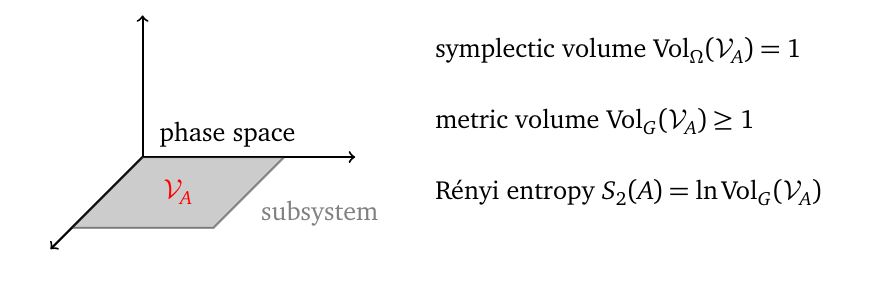
Figure 2: Geometric interpretation of Rényi entropy. We can interpret the Rényi en- tropy (of order 2) as the logarithm of the metric volume of a parallelepiped on the subspace A ∗ ⊂ V ∗ , whose symplectic volume is equal to 1. The metric volume is cal- culate by restrcting the covariance matrix G of the given state to the subspace A that contains V A